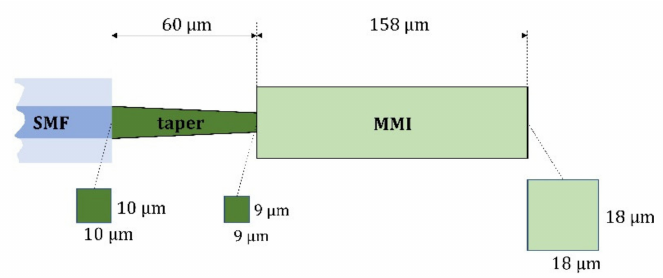
Figure 3. The MMI splitter geometry of the optical splitting part with corresponding